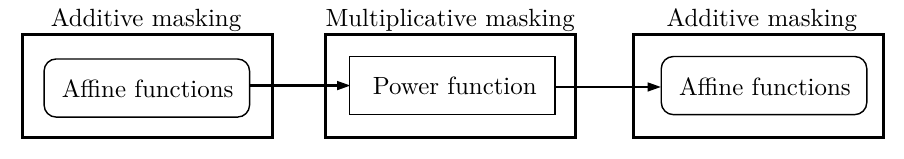
Figure 1: GPQ mixes additive and multiplicative